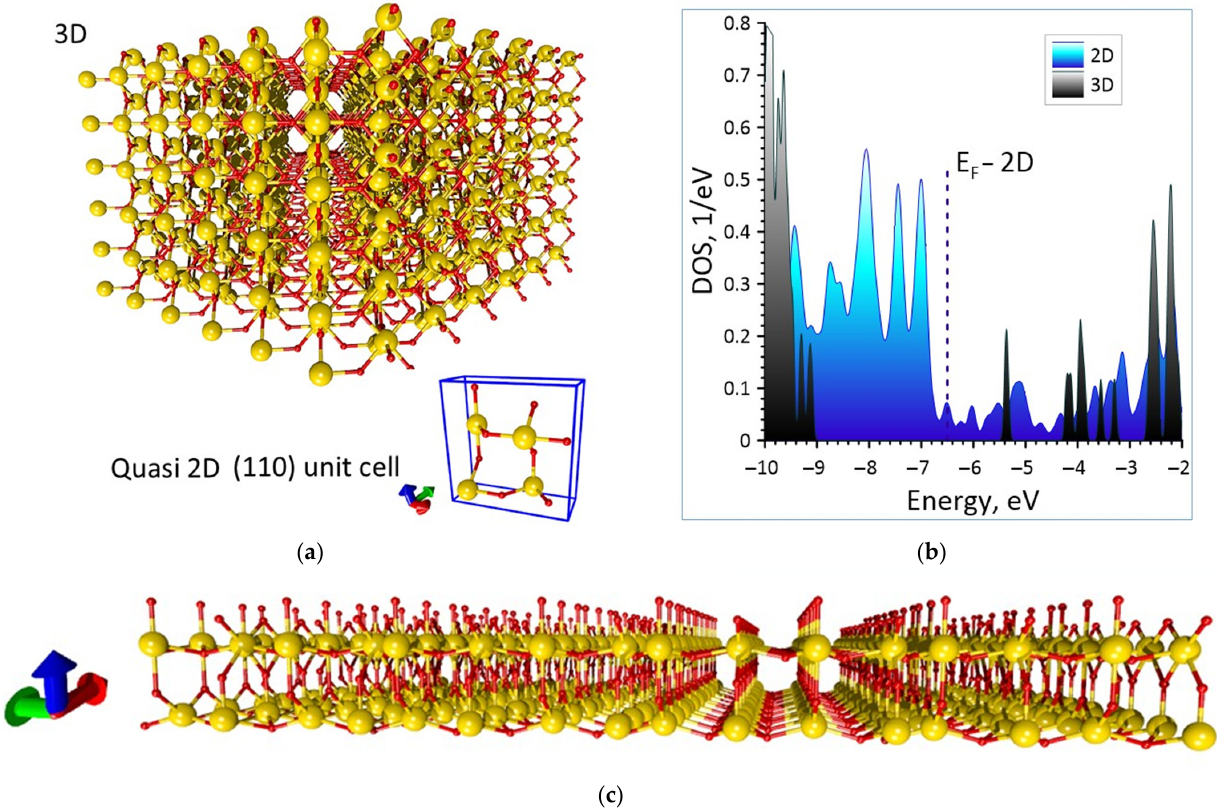
Figure 1. The atomic structure ( a ) and the DOS plot ( b ) of the SnO 2 3D crystal and quasi-2D film (in the blue box—unit cell of the film, yellow—marked tin atoms, red—oxygen). The fragment of a 5 × 5 × 1 unit cells film quasi 2D film ( c ).